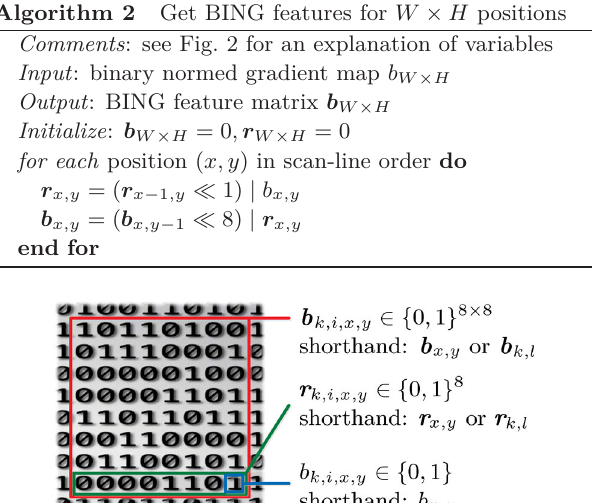
Algorithm 2 Get BING features for W × H positions